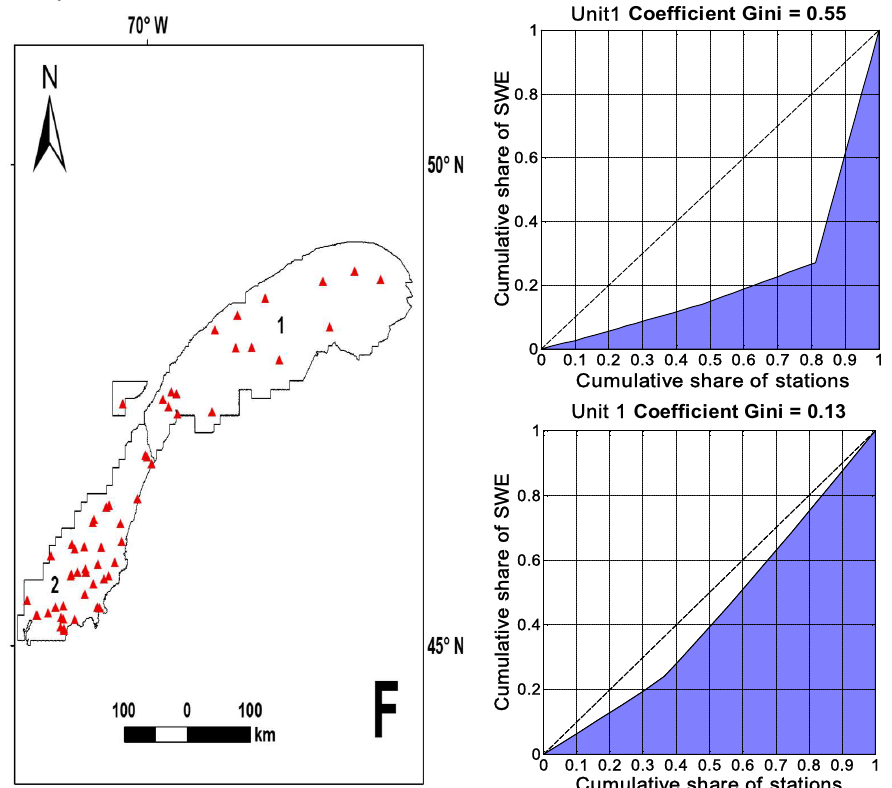
Figure 10. Lorenz curves and values of the spatial distribution unevenness of stations in the units of zone F, at the local scale.